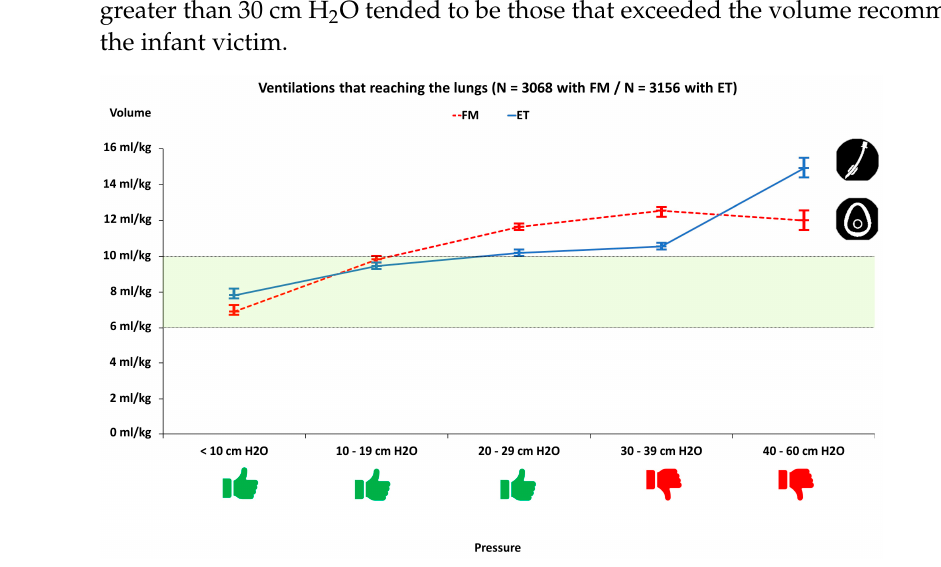
Figure 2. Relationship between pressures generated in the manikin’s airway and estimated volumes. FM: Face mask; ET: Endotracheal tube. Categories with a pressure of less than 30 cm H 2 O were considered safe.